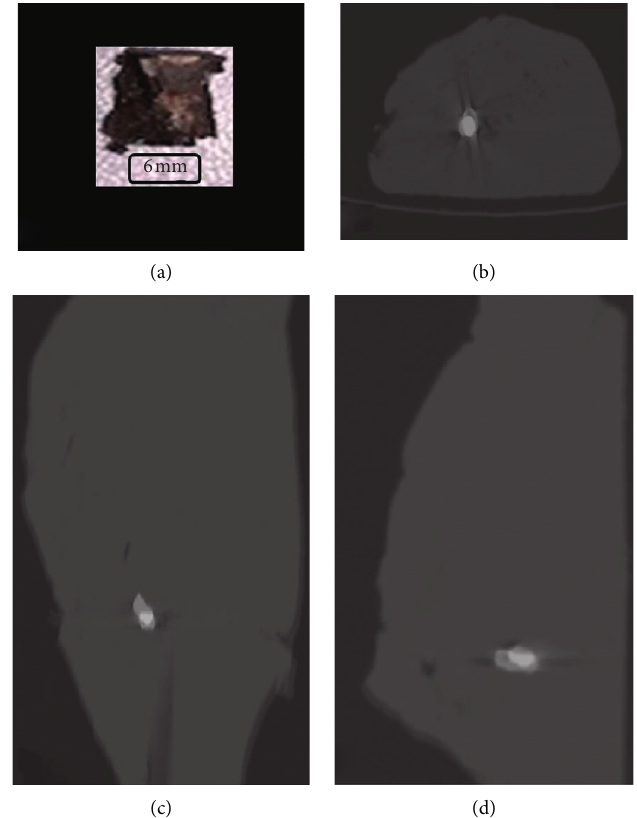
Figure 2: Shrapnel B (a). Fused images before and after MRI exposure in axial (b), coronal (c), and sagittal (d)